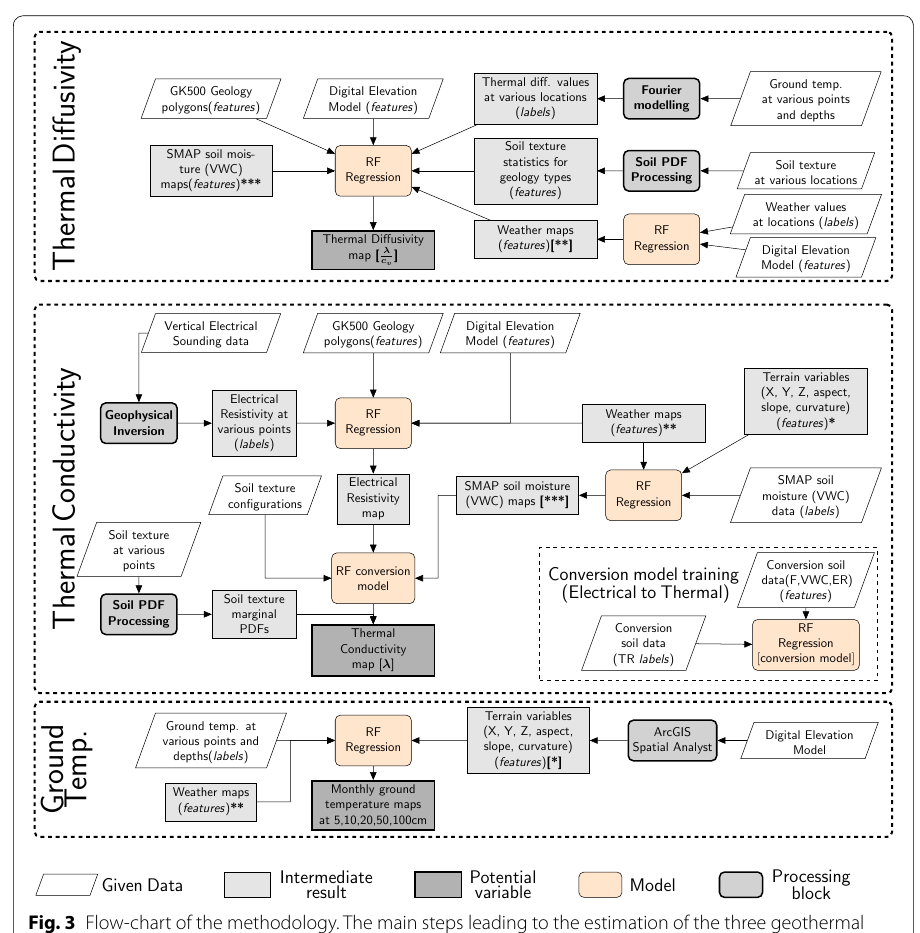
Fig. 3 Flow‑chart of the methodology. The main steps leading to the estimation of the three geothermal potential variables are summarized. In the Conversion model training box, “TR” signifies Thermal Resistivity and “ER” signifies Electrical Resistivity. Also, note that some Intermediate boxes appear multiple times (Weather maps, SMAP soil moisture maps, and Terrain variables). In order to avoid repeating the same information, the processing leading to each box is shown once, with a superscript between brackets (e.g., [*]). All the other times the box is used, it is associated with the same superscript with no